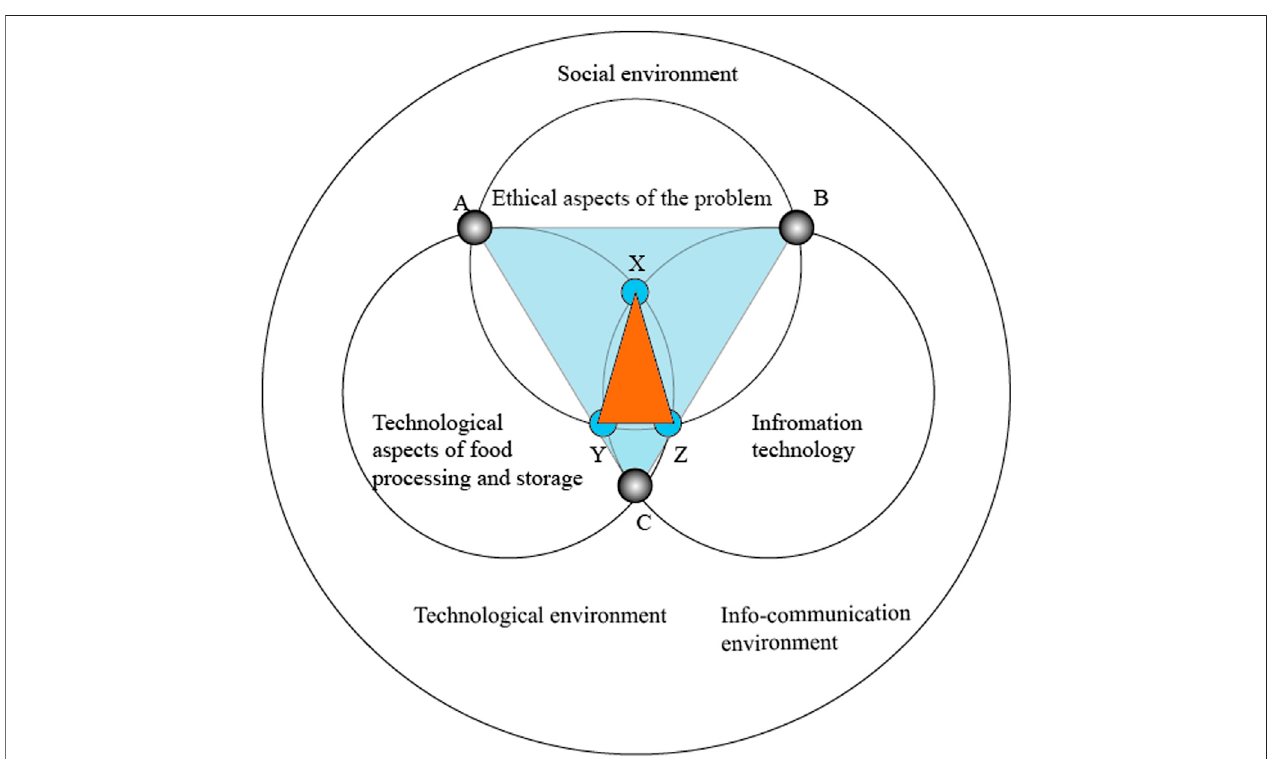
FIGURE 11 | The triple helix structure of factors in fl uencing the development of food waste related policies.